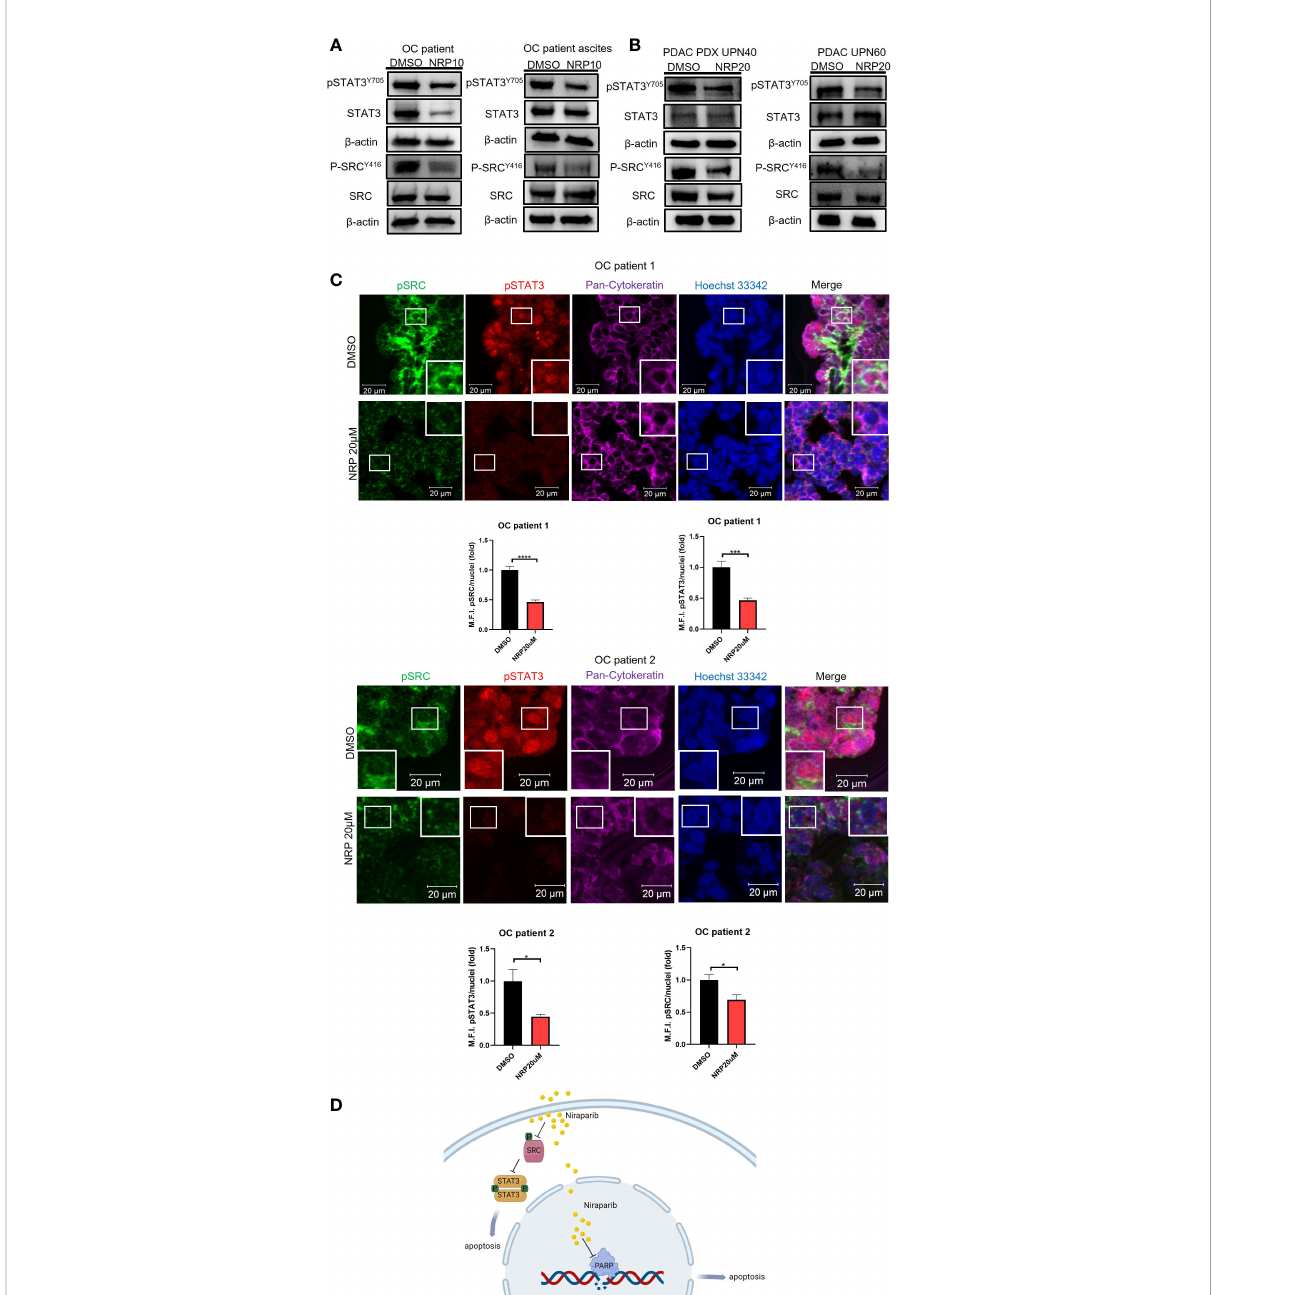
FIGURE 4 NRP treatment reduces pSTAT3 and pSRC in OvCa and PDAC patient tumor samples. (A) Western blot analysis of pSTAT3 and pSRC levels in OvCa patient primary tumor cells or ascites cells after 24h NRP treatment. b -actin served as a loading control. (B) Western blot analysis of levels of pSTAT3 and pSRC in PDAC-derived PDX tumor cells or PDAC patient primary tumor cells treated with NRP for 24h. b -actin served as a loading control. (C) Expression of pSTAT3 and pSRC in OvCa patient tumor slices treated with DMSO or NRP for 24h were examined by fl uorescent immunohistochemistry and confocal microscopy. Representative images are shown from two OvCa patients. Red, pSTAT3; Green, pSRC; Magenta, pan-Cytokeratin; Blue/Hoechst 33342, nucleus. Cytokeratin-positive cell clusters demonstrate malignant tumor tissue. Scale bars = 20 m m. Histograms show quanti fi cation of M.F.I. of pSTAT3 and pSRC normalized to nuclear staining. Quanti fi cation was performed using ImageJ software, and at least fi ve fi elds were quanti fi ed for each condition group. Data are presented as mean ± SEM. Unpaired